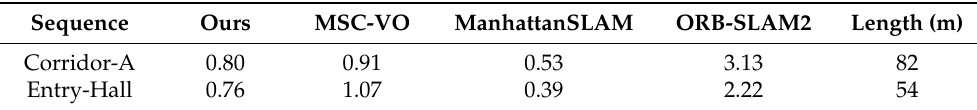
Table 6. Comparison of the accumulated drift (m) in TAMU RGB-D